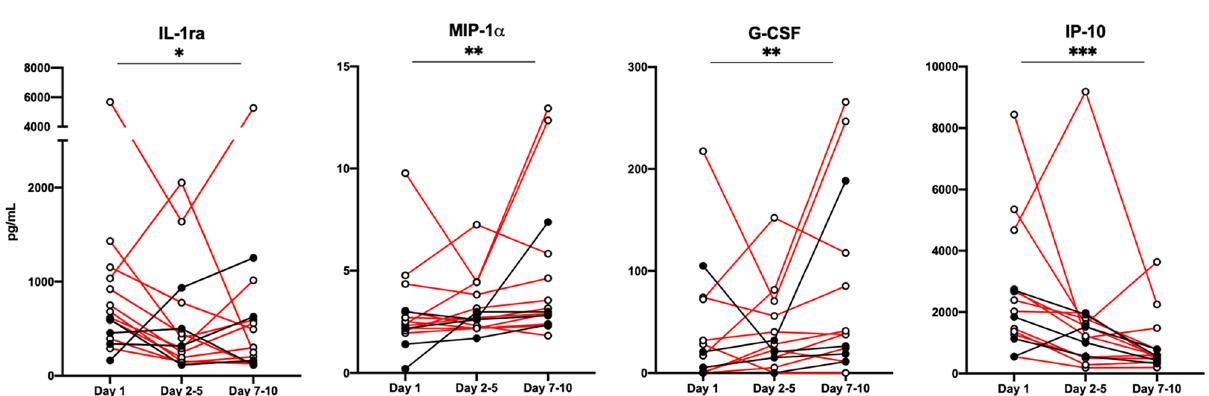
Figure 5. Longitudinal cytokine levels in COVID-19 patients during hospitalization. Measurement of plasma cytokine levels at day 1 (n = 15), day 2–5 (n = 15) and day 7–10 (n = 15) after hospitalization. Scatter plot displaying individual values of longitudinal data showing a significant change in the levels of four cytokines. Significance calculated with Friedmans test, * < 0.05, ** < 0.01, *** < 0.001. Patients with RF (n = 11) are shown in